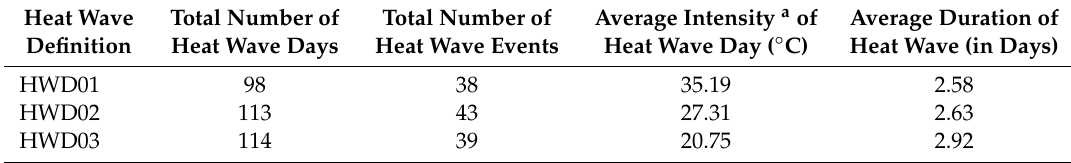
Table 3. Summary of heat wave characteristics for each heat wave definition